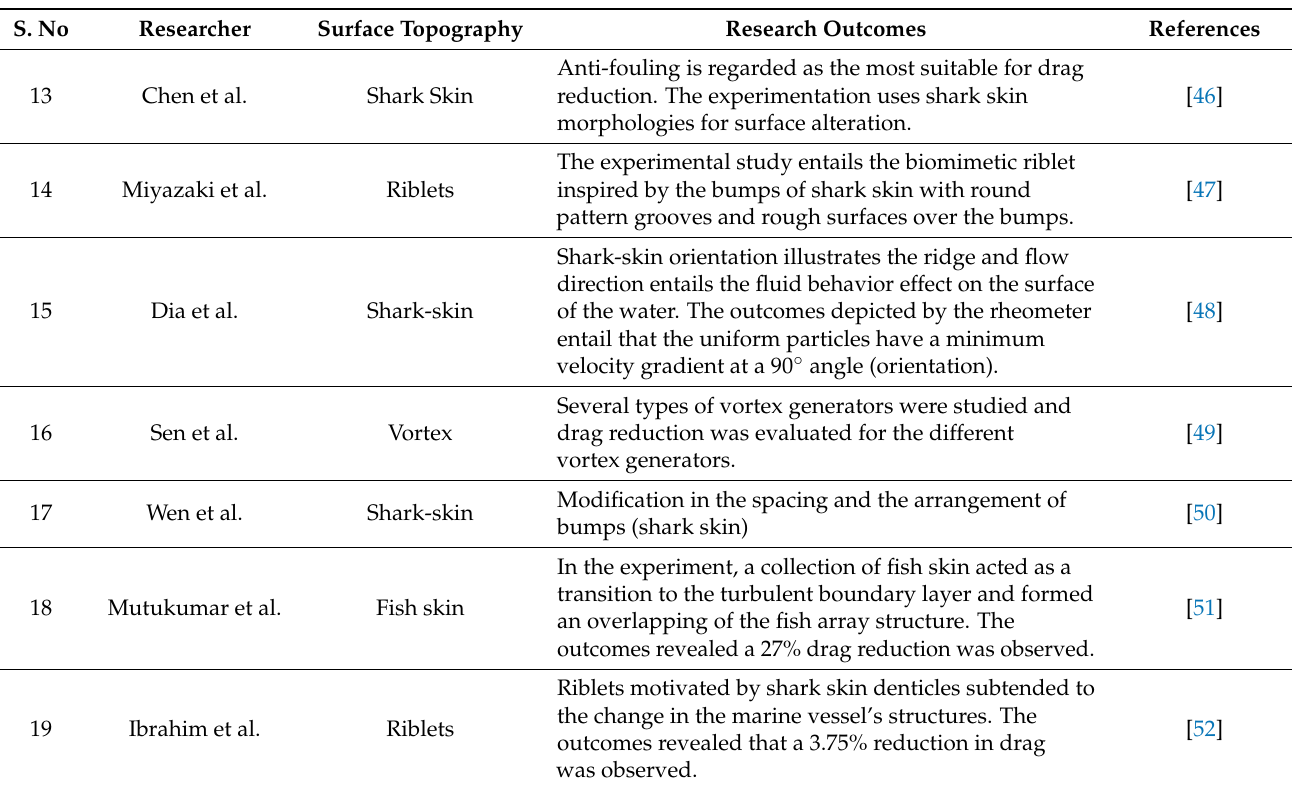
an overlapping of the fish array structure. The outcomes revealed a 27% drag reduction was observed. Riblets motivated by shark skin denticles subtended to the change in the marine vessel’s structures. The outcomes revealed that a 3.75% reduction in drag was